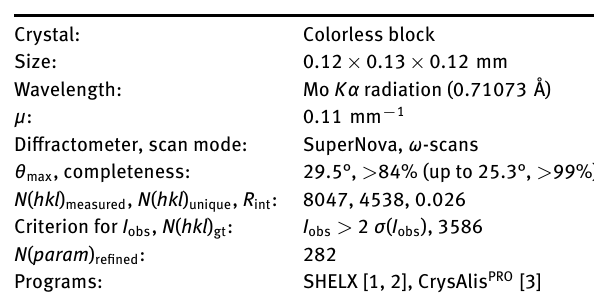
Table 1: Data collection and handling.